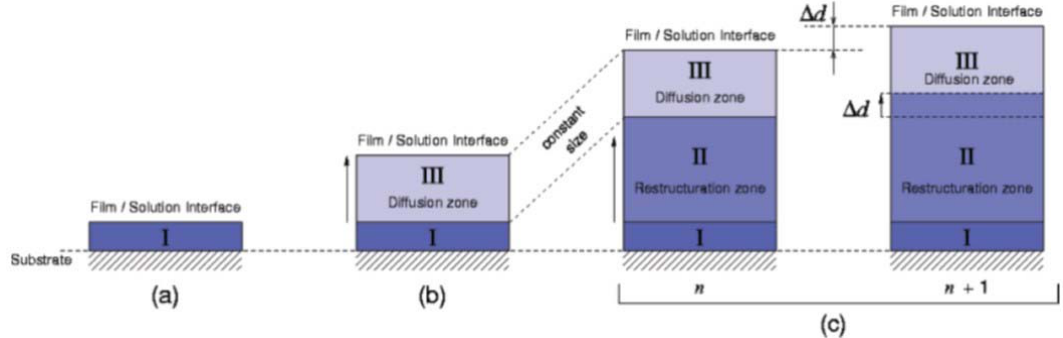
Figure 1. Schematic representation of a polyelectrolyte (PEL) multilayer (PEM), fabricated by consecutive deposition of polycations and polyanions taken from Reference [17]. (Reproduced with kind permission of ACS). Meanings of zones I, II and III are explained in the text below. ( a ), ( b ) and ( c ) denote early, medium term and late period of PEM growth, n the PEL deposition step and ∆ d denotes the thickness increment per n .